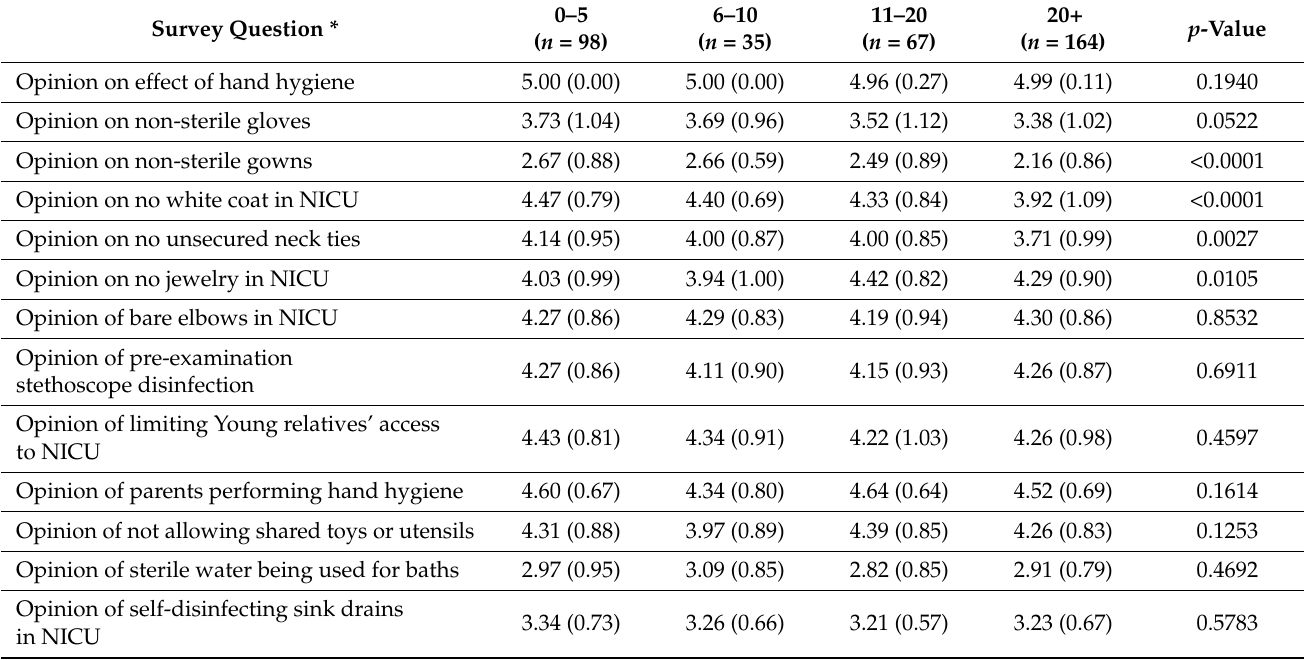
Table 5. Likert Opinion Scores, Stratified by Years of